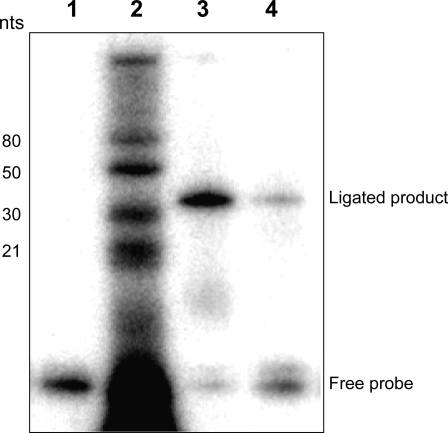
Splinted ligation of miR2.Size fractionated RNA (<40 nts) was analyzed by splinted ligation for the presence of miR2. (Lane 1) Negative control containing only the labeled RNA probe. (Lane 2) RNA markers. (Lane 3) Positive control using a synthetic miR2. (Lane 4) Size fractionated RNA (200 ng) from Giardia WB trophozoites. The presence of a discrete band migrating to the same position with the positive control suggests the presence of miR2 in the small RNA population.